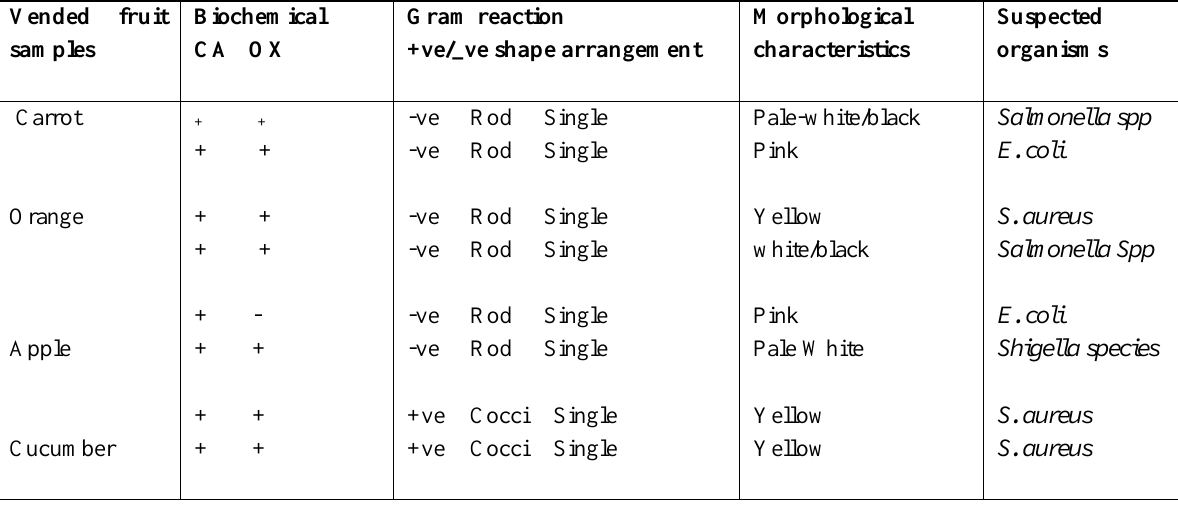
Table 2. Morphological and biochemical characteristics of the microbial isolates from the ready- to-eat vended fruit